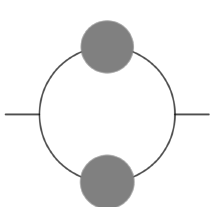
Figure 3 . The self-energy of the Amit-Roginsky model. Full propagators are represented by the gray